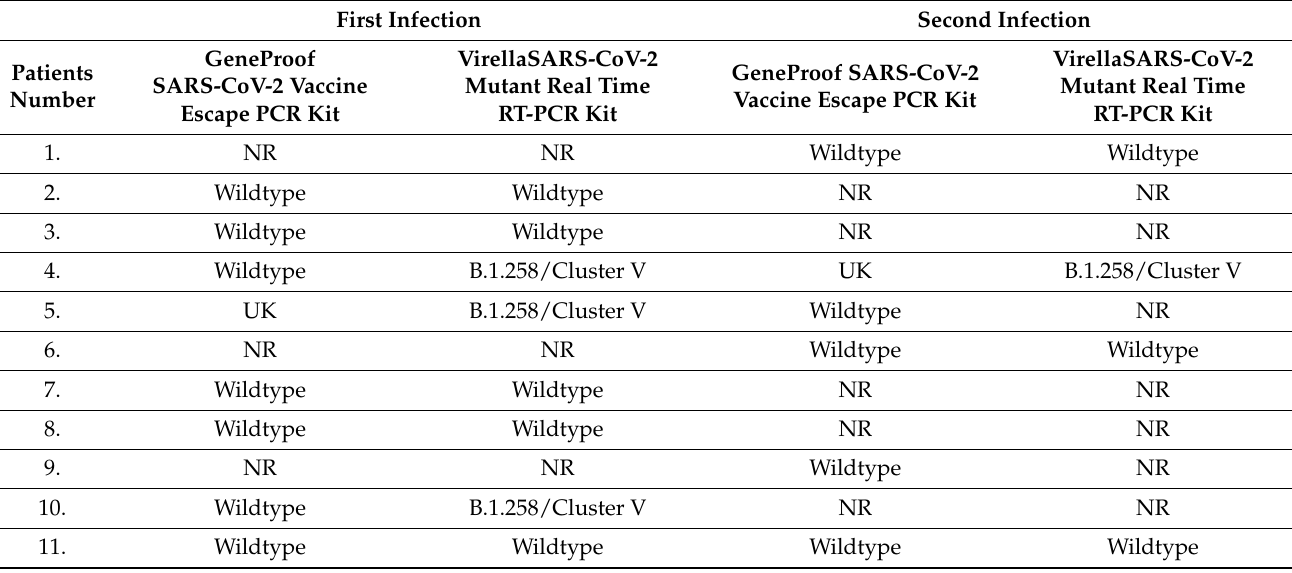
Table 3. Interpretation of results for the identified SARS-CoV-2